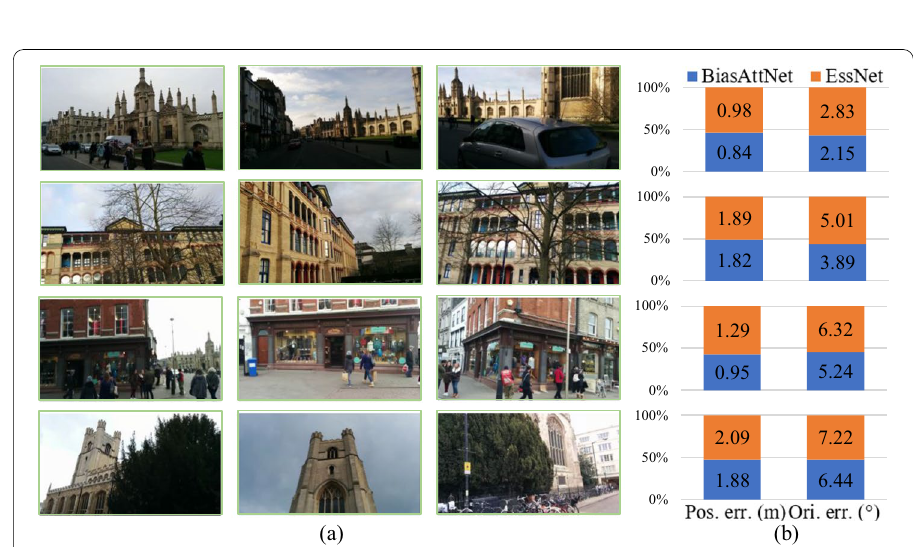
Fig. 9 Performance results of challenging images. a Some representative query images that contain interfering objects. b Stacked bar charts of position error and orientation